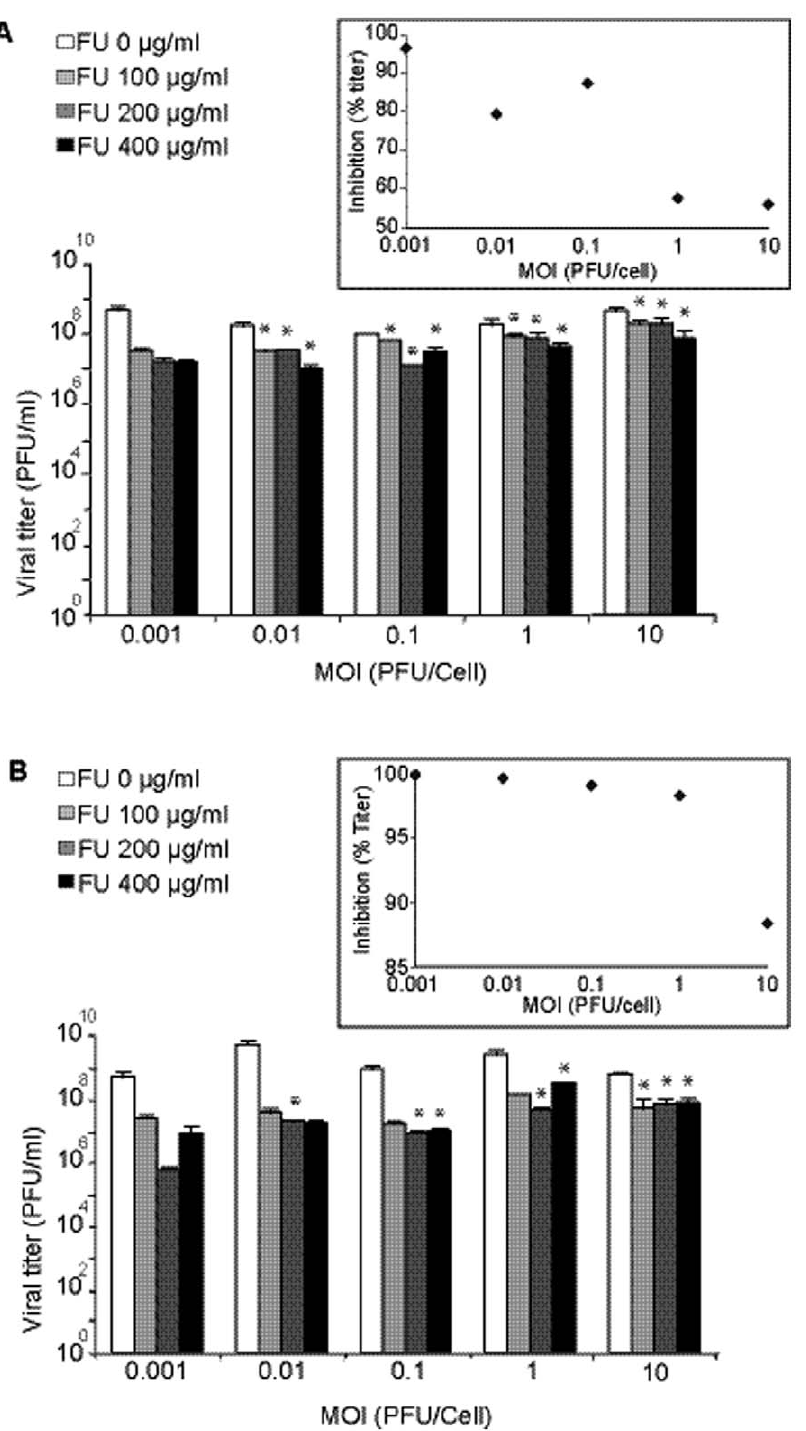
Figure 6. Effect of the multiplicity of infection (MOI) on the inhibition of mutagenized and non-mutagenized EMCV progeny production by 5-fluorouracil (FU). A. BHK-21 cells were infected with EMCV passaged 20 times in absence of ribavirin at the indicated MOI, in the absence (white bars) or presence of different concentrations of FU (increasingly dark bars), as indicated in each panel. Cell culture supernatants were harvested at 24 h p.i. and titered. Viral titers are the average of at least three determinations and standard deviations are given. The inset visualizes the variation of the percentage of inhibition (by 200 m g/ml FU) as a function of the MOI. B. Same experiment, but using a EMCV passaged 20 times in the presence of 800 m M ribavirin. The asterisks above the bars indicate the FU-inhibition values that are significantly different from those obtained with the corresponding lowest MOI tested. The inset is as in panel A. Procedures are described in Materials and Methods.